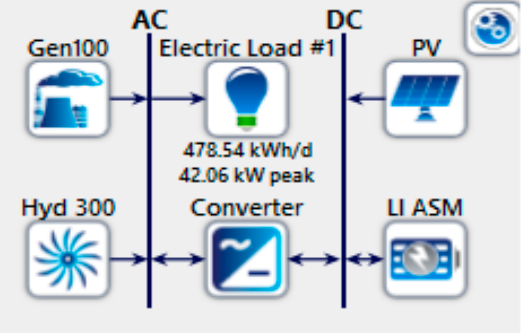
Figure 14. HOMER system architecture showing the interconnections of the loads, components, and resources.